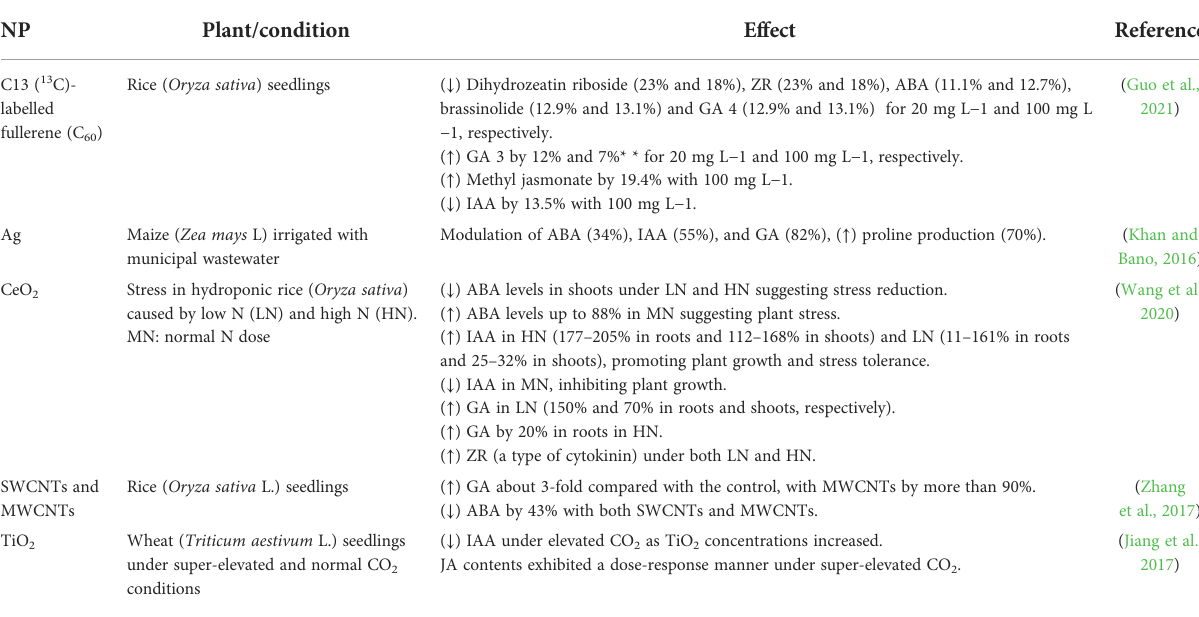
TABLE 2 Stimulation of growth regulators by